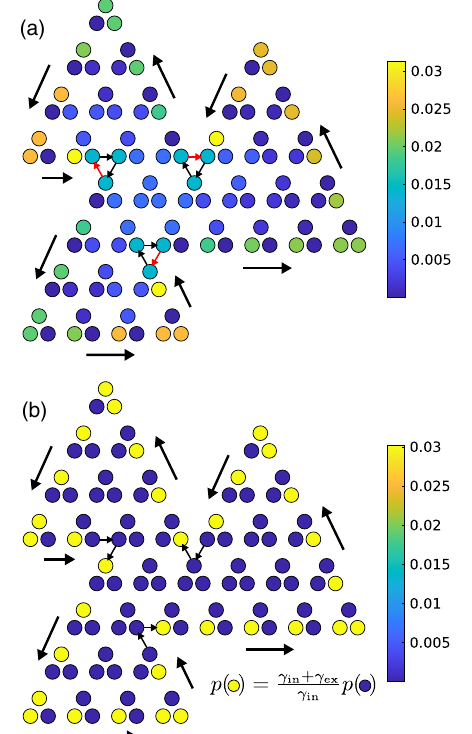
FIG. 9. Edge currents and the resulting cycles are robust with respect to the shape of the boundaries, also in the case of the three-state (kagome) lattice. However, in contrast to the four-state model, in this case, one must make sure that corner-cutting transitions across concave corners of the lattice are absent, as otherwise such corners scatter probability into the bulk. In diagram (a), corner-cutting transitions are present (red arrows), and the three concave corners scatter probability into the bulk, making the steady-state probabilities sensitive to the shape of the system. In diagram (b), corner-cutting transitions are absent, the edge current does not scatter, and the steady-state probabilities are independent of the shape of the system. The steady states have been calculated from the direct solution of the master equation, 10 − 3 γ for a fully chiral system with γ in ¼ ex